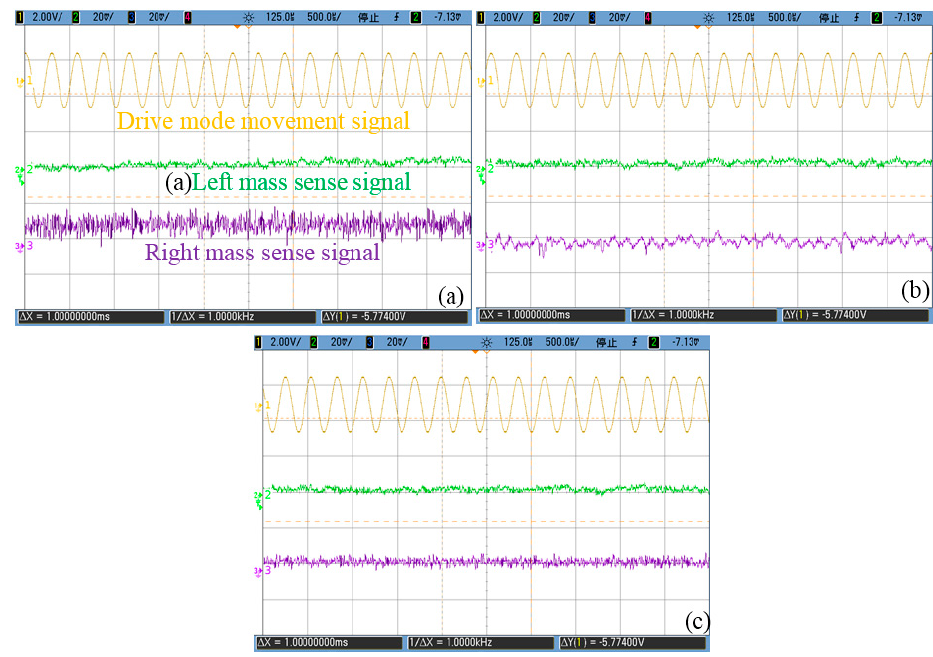
Figure 14. ( a ) CIC system testing results; ( b ) QFC system testing results; ( c ) CSC system testing results.